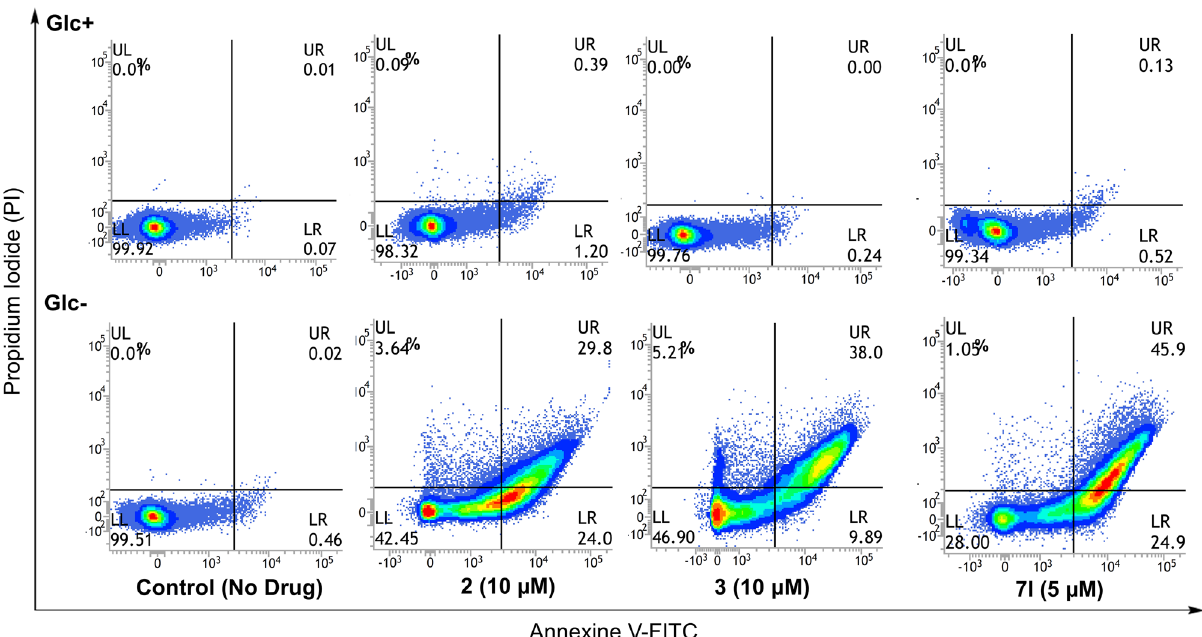
Figure 6. FACS analysis of apoptosis in HT29 treated with 2, 3 and 7l for 48 h in normal (2000 mg/L glucose, Glc +) or glucose-free (Glc −)